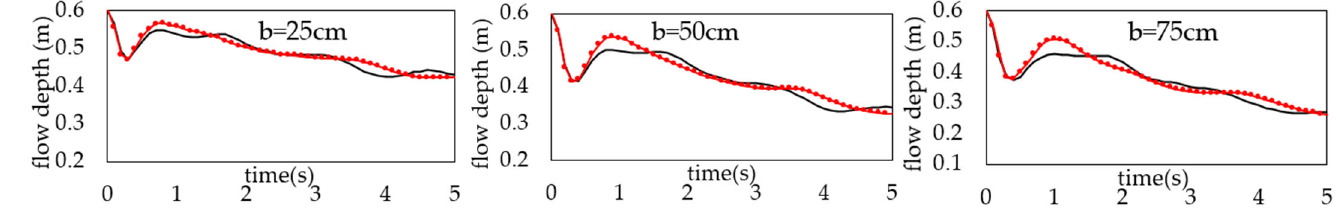
Figure 8. Distribution of transverse v velocity near dam site at t = 1.5 s.